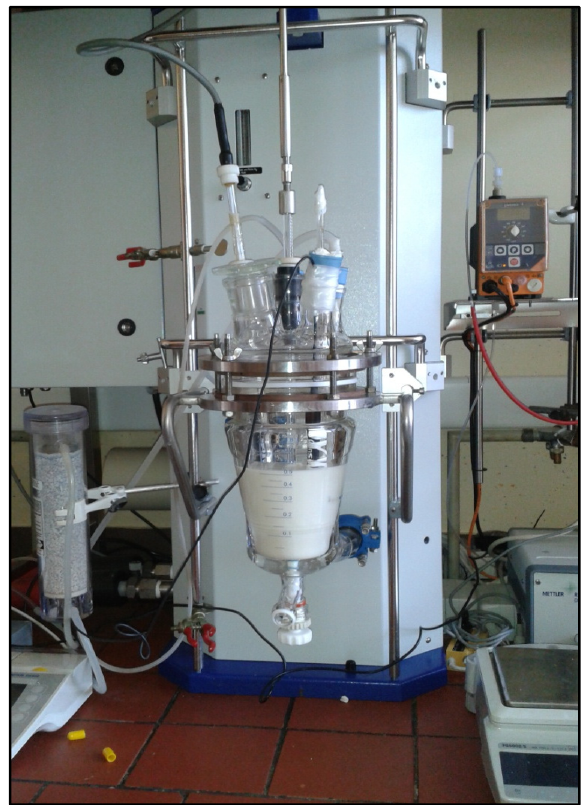
Figure A11. Laboratory batch bioreactor RC1e from Mettler Toledo. Figure A1. Laboratory batch bioreactor RC1e from Mettler